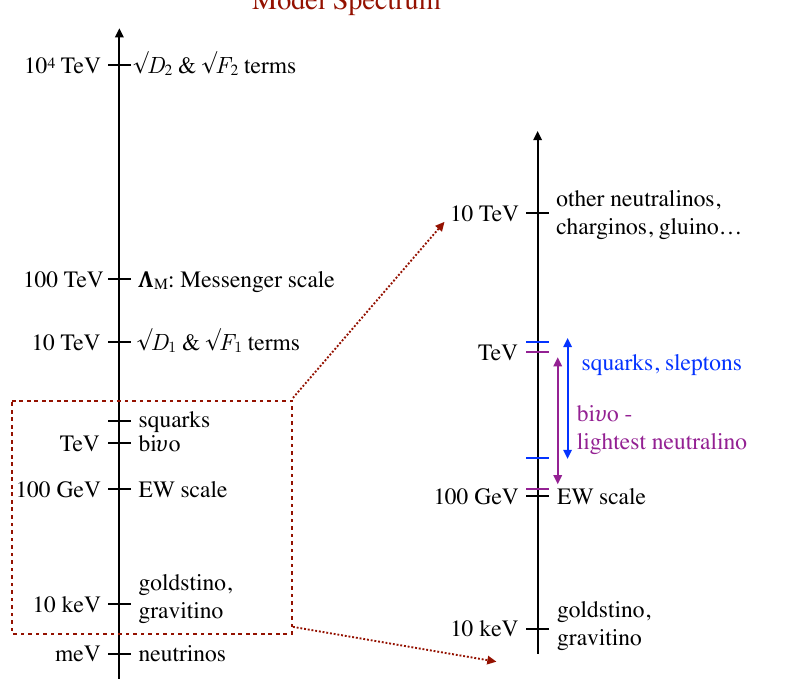
Figure 1. Approximate spectrum of particles in the model described in section